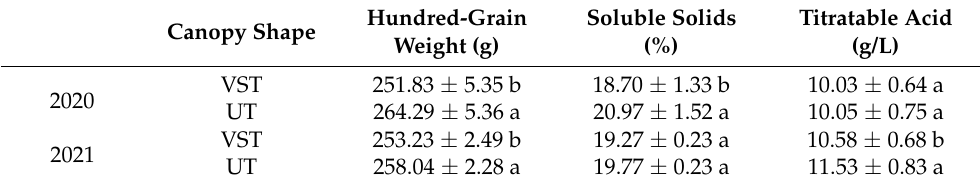
Table 2. Effect of canopy types on the fruit size, soluble solids, and titratable acid content.